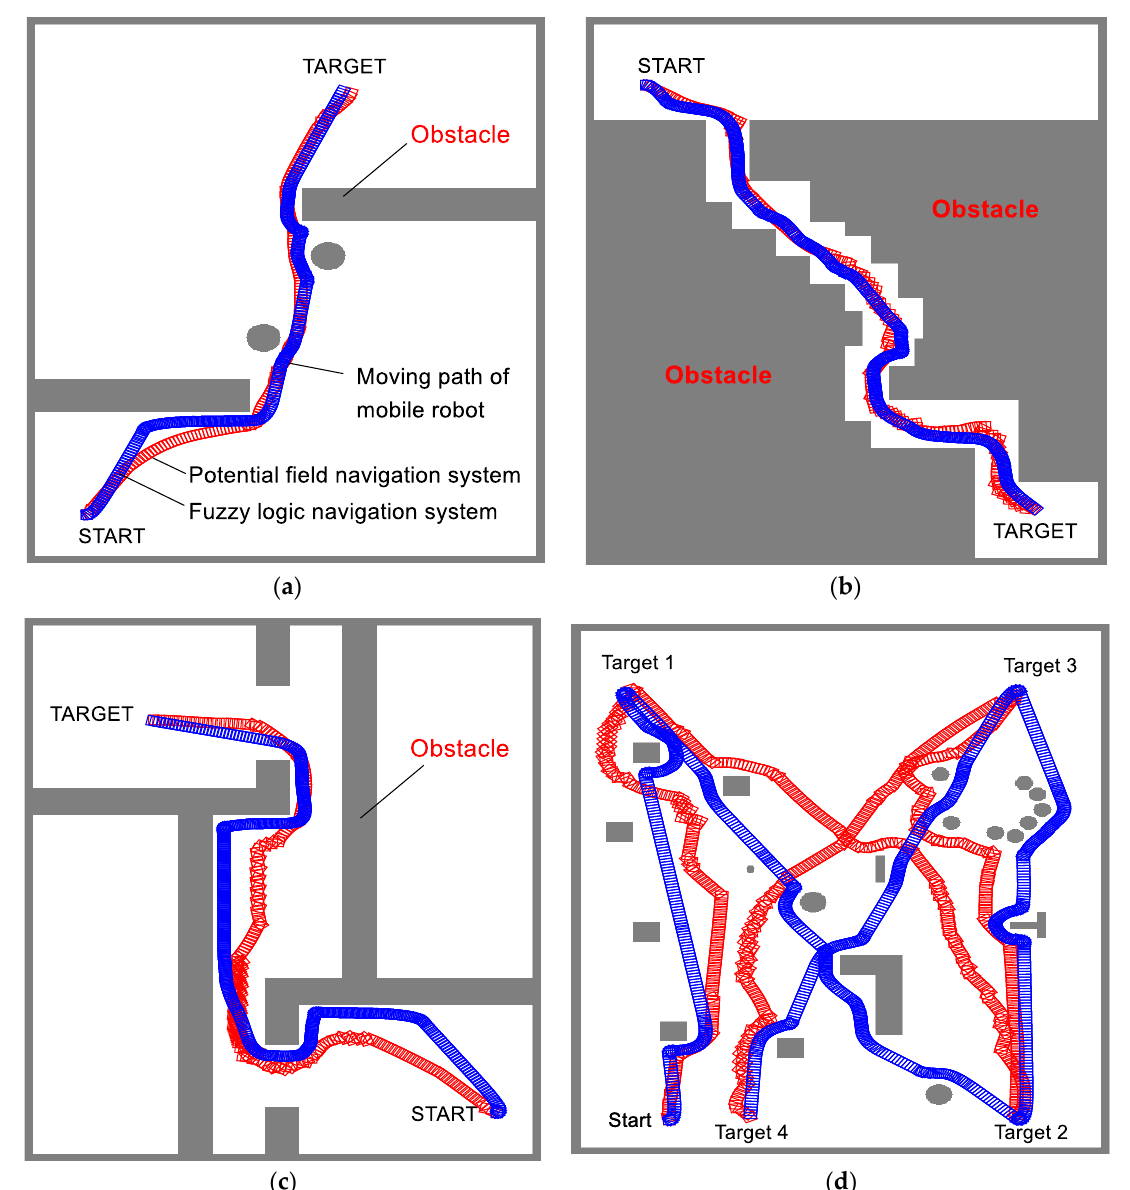
Figure 13. Simulation results of autonomous fuzzy navigation system with fuzzy positioning — ( □ : navigation path using fuzzy logic navigation system, □ : navigation path using potential field navigation system): ( a ) navigation path to reach target after avoiding obstacles; ( b ) navigation path in narrow pathway; ( c ) navigation path to reach to the target in a room; ( d ) navigation path to reach multiple targets.